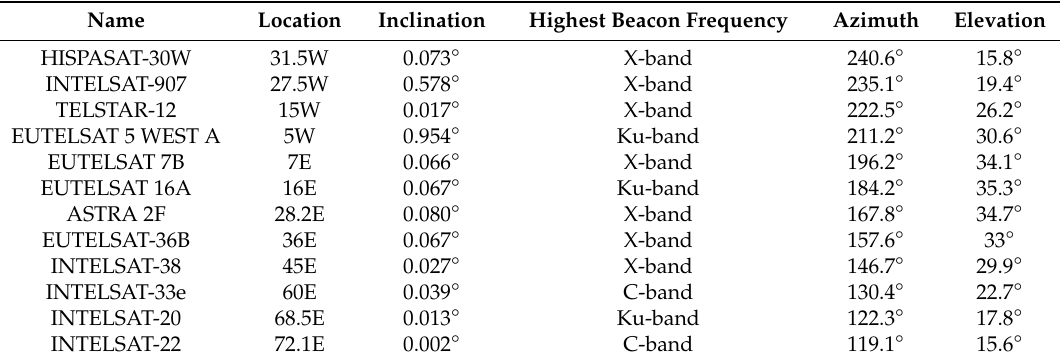
Table 1. Parameters of satellites selected for the simulations. Azimuth and elevation degrees are calculated for Budapest, 96 m above sea level.